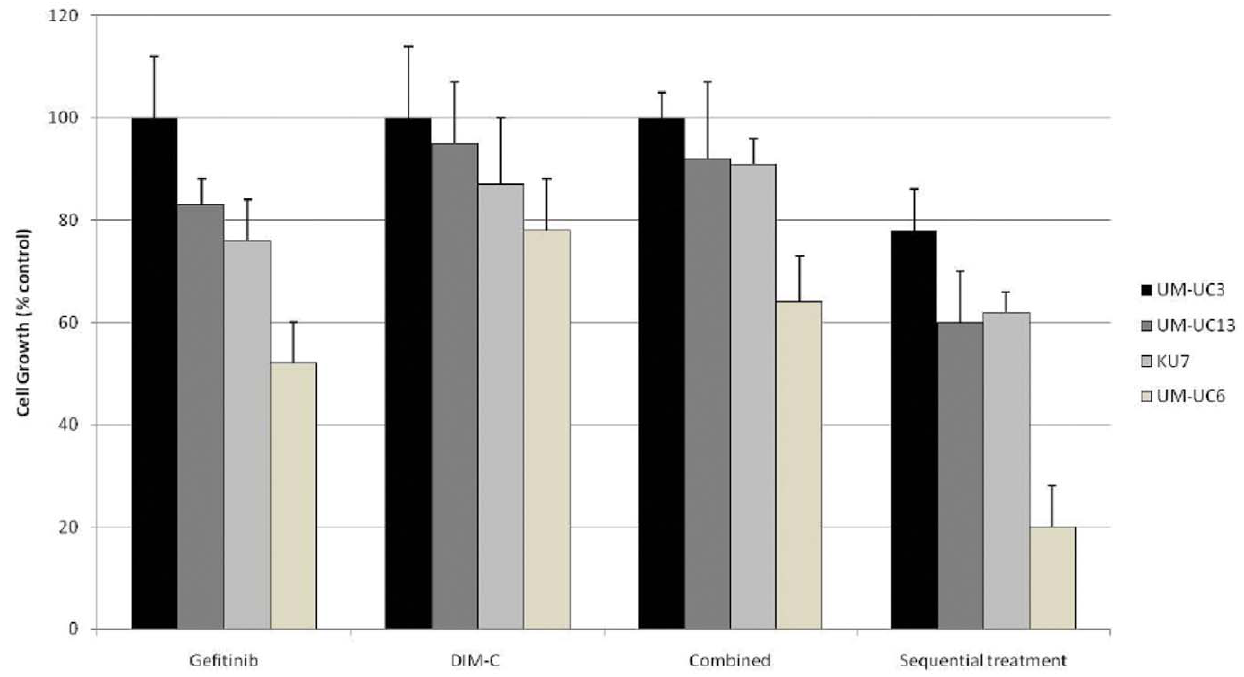
Figure 8. Schedule-specific efficacy of combination therapy. Three relatively resistant cell lines to gefitinib (UM-UC3, UM-UC13, and KU-7) and one sensitive (UM-UC6). Growth (MTT assays) after 48 hs treatment. Gefitinib: 2 m M. DIM-C: 2 m M.